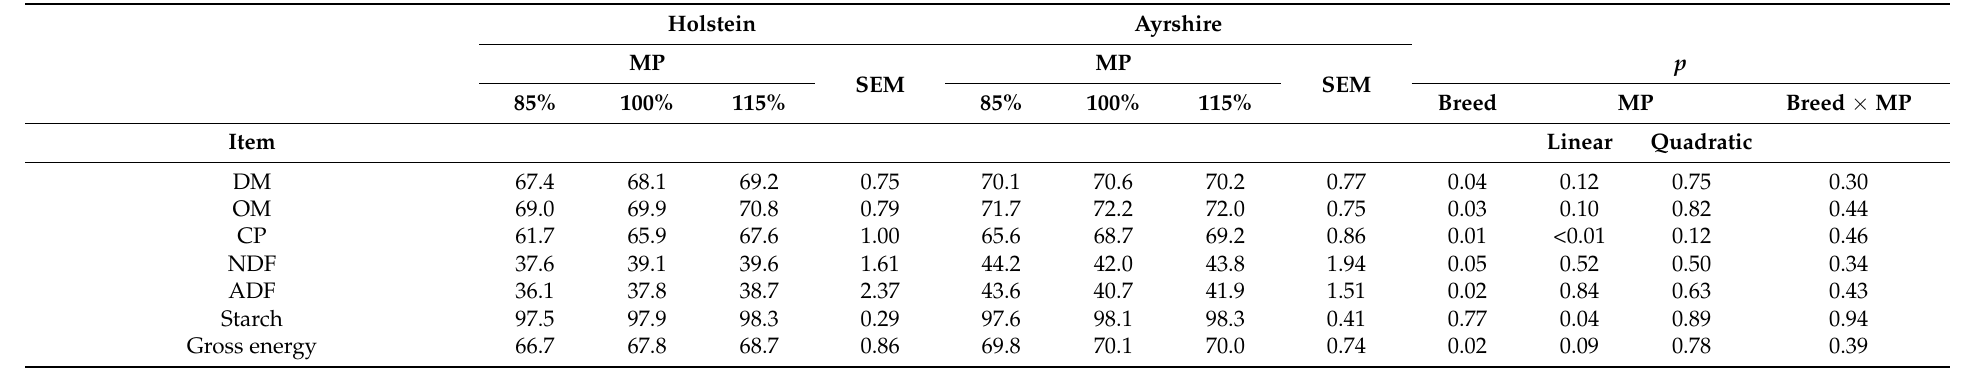
Table 5. Apparent total-tract digestibility (%) of nutrients in lactating Holstein and Ayrshire cows fed diets formulated to provide 85%, 100%, or 115% of metabolizable protein (MP) requirement 1 .